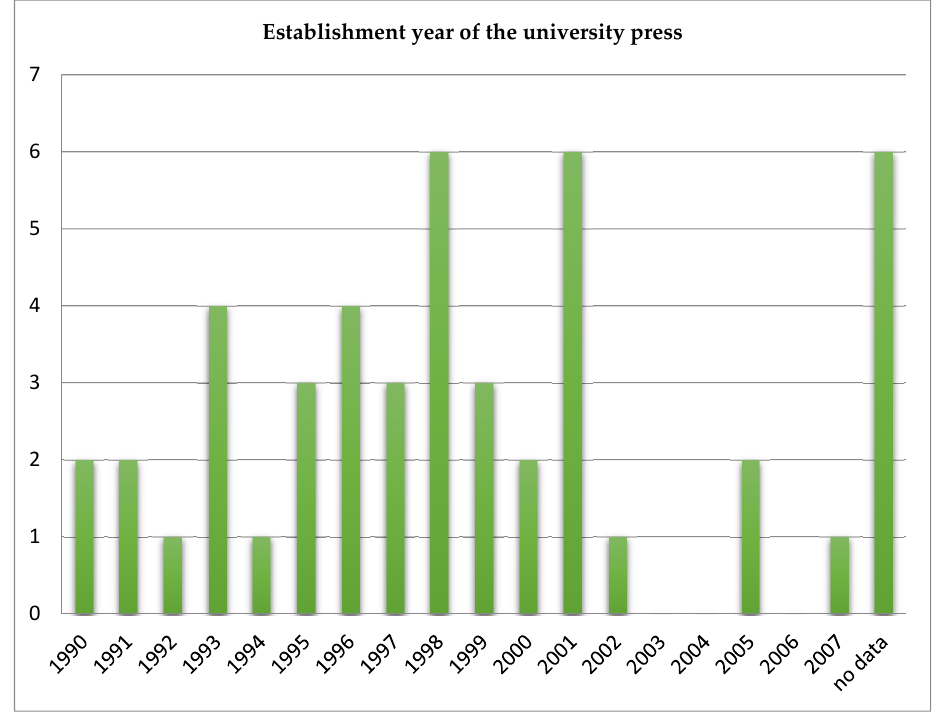
Figure 2. Dynamics of establishing university presses in Romania.